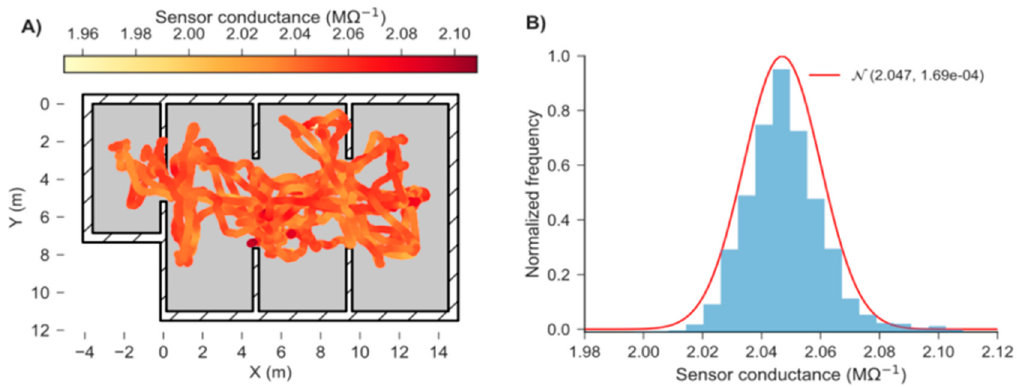
Figure 10. ( A ) 2D map of MOX sensor response during 15 minutes of random exploration of the target area without gas; ( B ) Histogram of blank readings, with a Gaussian curve N ( µ , σ 2 ) superimposed.